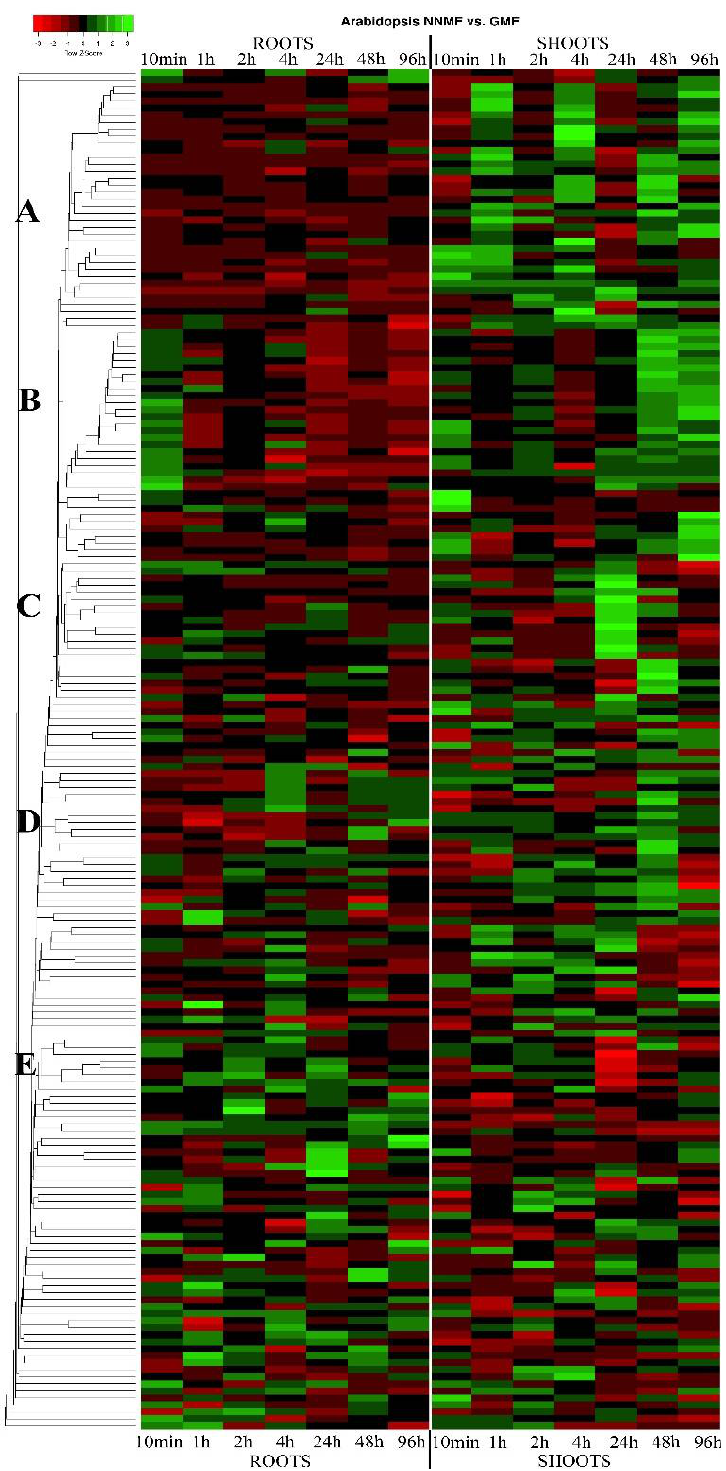
Figure 2. Heatmap of genes coding for enzymes involved in oxidation reactions from the time-course microarray gene expression of A. thaliana grown in a near-null magnetic field (NNMF) compared to geomagnetic field (GMF) grown plants. The heatmap was generated by using a single linkage clustering method and Pearson distance measuring method. Downregulated genes are marked in red-shaded colors, whereas upregulation is evidenced by different shades of green. Five groups of genes are evidenced (see text for more details).